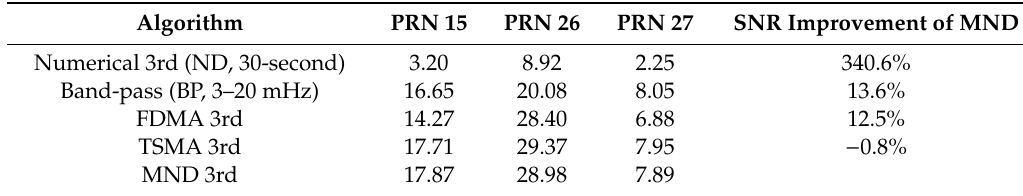
Table 3. Average values of the SNR for 45 NGII stations, using the best N values and SNR improvements of MND from other